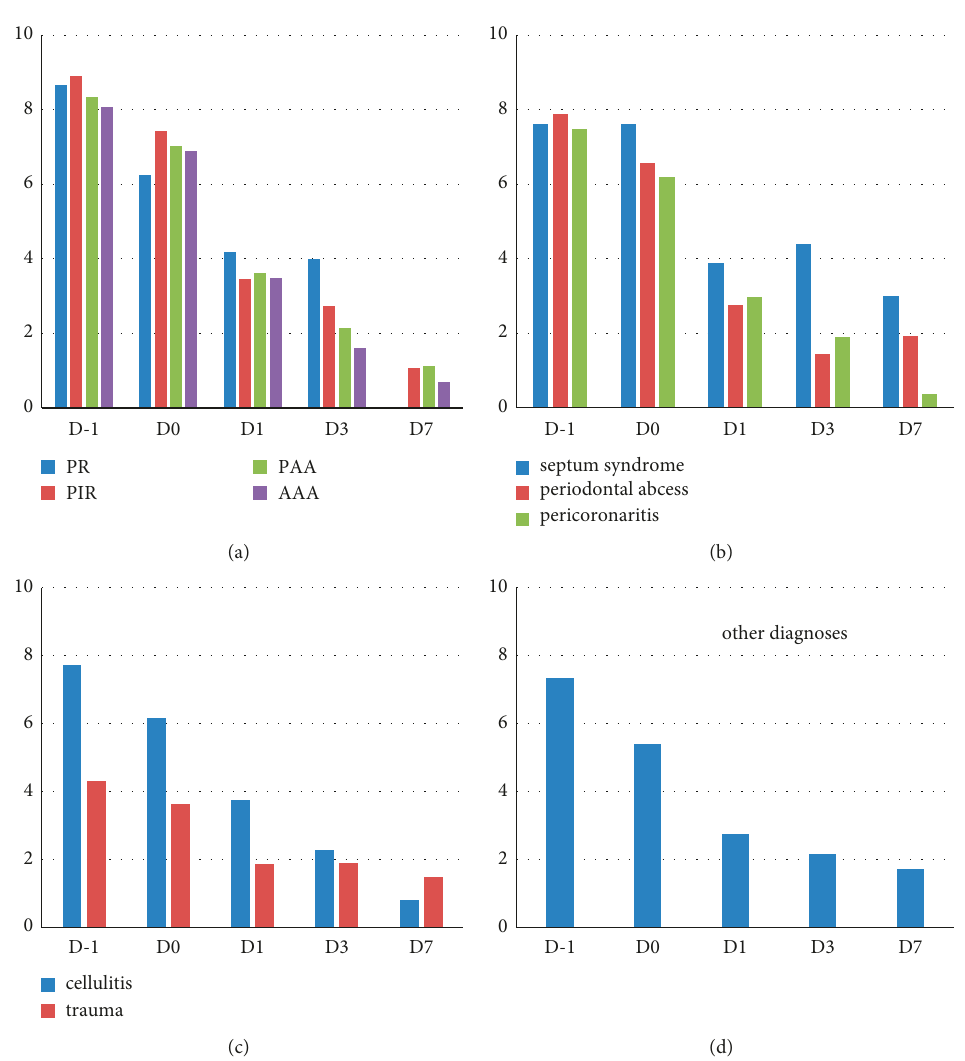
Figure 3: Distribution of self-evaluated [0–10] pain scores (ordinates) on D1–D7 (abscissae) according to diagnosis. (a) Pulpal pain (AAA, PAAA, PIR, PR). (b) Periodontal pain (septum, periodontal abcess, pericoronitis). (c) Cellulitis and traumas. (d) Other diagnoses including TMD, oral mucosal pathologies, and prosthodontics. Note. PR: reversible pulpitis, PIR: irreversible pulpitis, AP: acute apical periodontitis, AAA: acute apical